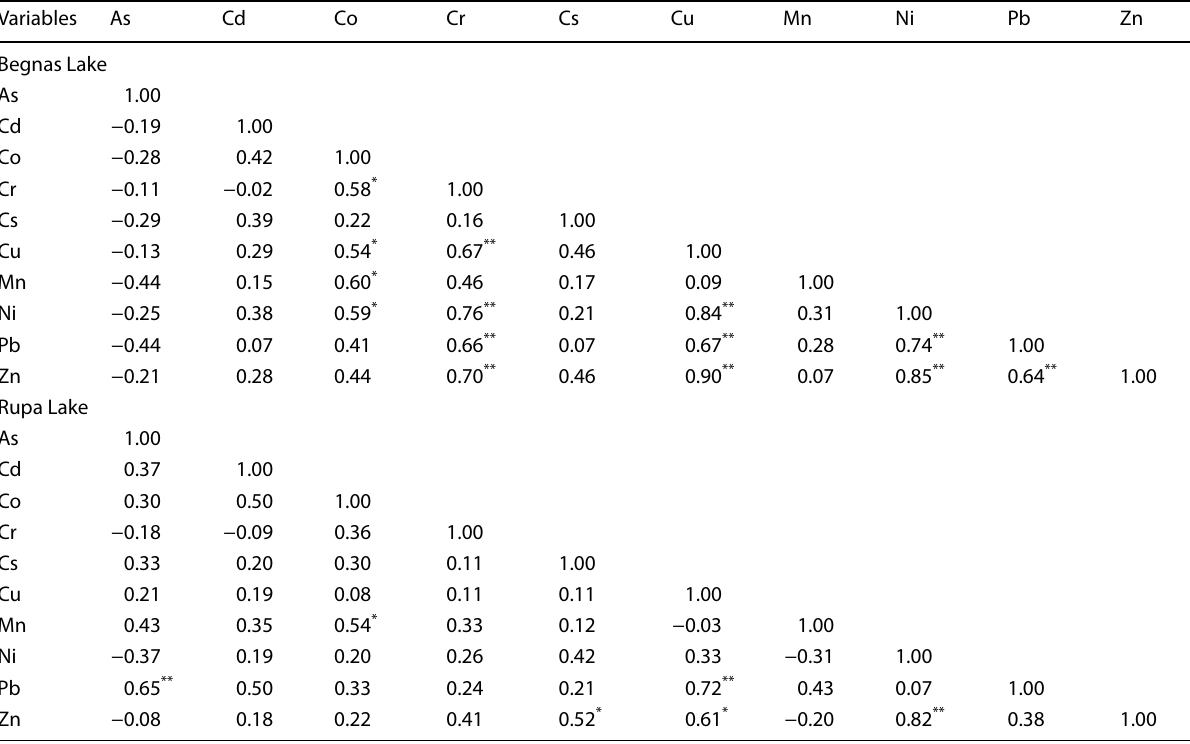
Table 4 Correlation matrix of TTEs in Begnas Lake and Rupa Lake Variables